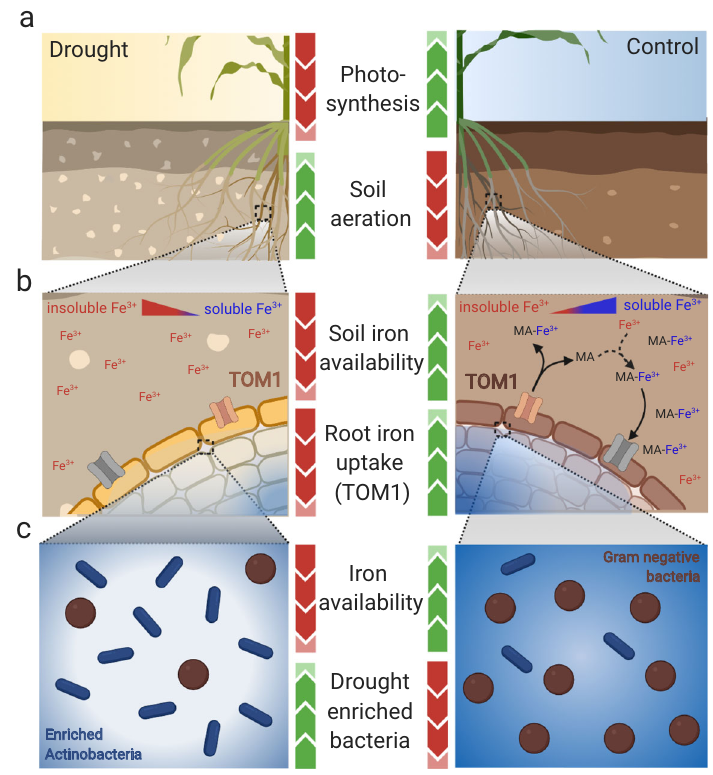
Fig. 8 Model of interaction between iron, drought, and the root microbiome. a During drought stress, sorghum experiences a decrease in photosynthesis and consequent reduced need for iron uptake by the root. Simultaneously, the surrounding soil environment becomes increasingly aerobic as water is removed from soil pores. b Increased soil aeration leads to reduced iron availability for plants and microbes, as iron becomes increasingly stored as insoluble Fe 3 + (shown in red text). Simultaneously, due to decreased need for iron and increased levels of ROS present within root tissues, sorghum roots decrease expression of iron-uptake machinery, including TOM1, which exports the phytosiderophore mugenic acid (MA) to the rhizosphere to solubilize Fe 3 + (shown in blue text). Collectively, this leads to less-solubilized iron in the rhizosphere, and decreased available iron within the root compartment. c The resulting low iron availability in root and rhizosphere environments promotes the growth of drought-enriched bacterial taxa (shown in blue) with high copy number of iron transport and metabolism-related genes, which are able to better scavenge the limited iron than drought-depleted lineages (shown in brown). This fi gure was created using